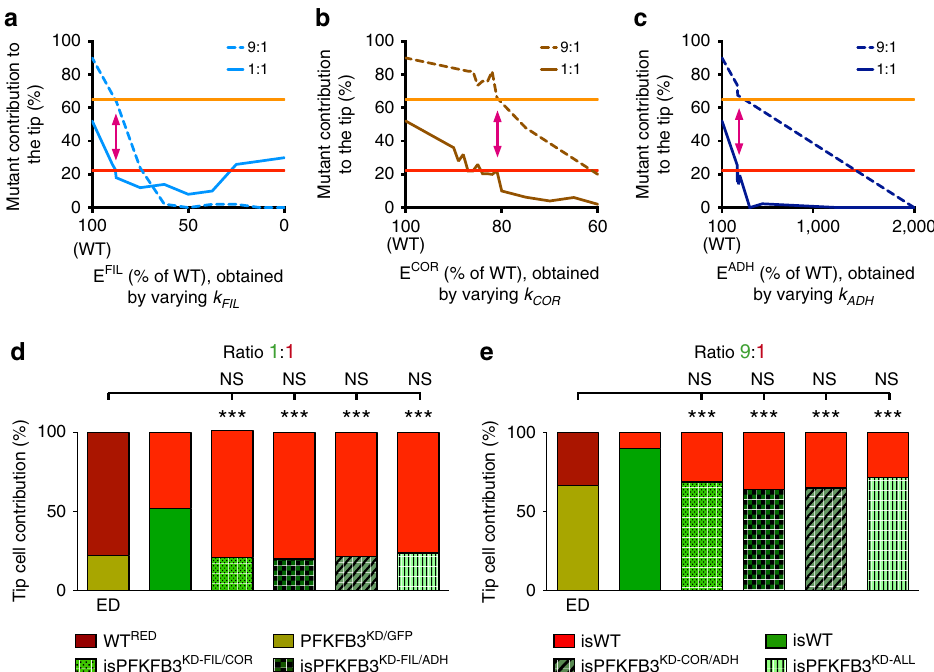
Figure 2 | Effector mechanism simulations of tip cell contribution. ( a–c ) Sensitivity analyses of respectively E FIL ( a ), E COR ( b ) and E ADH ( c ) as single mechanism governing tip cell competition, by varying over a wide range values of respectively k FIL , k COR and k ADH . The results for both the 1:1 (full line) and 9:1 (dashed line) in silico PFKFB3 KD :WT (isPFKFB3 KD :isWT) mosaic sprouts are shown. The red and orange horizontal line depict the tip cell contribution of PFKFB3 KD cells, as obtained experimentally in respectively the 1:1 and 9:1 PFKFB3 KD :WTsprouts 5 . The combined 1:1 and 9:1 simulation results yielded one specific k value (see pink double-headed arrow) for every single effector mechanism. ( d,e ) Combinatorial E FIL/COR , E FIL/ADH , E COR/ADH and E ALL simulations of tip cell contribution in 1:1 ( d ) or 9:1 ( e ) isPFKFB3 KD :isWT mosaic sprouts, illustrating that for every combinatorial effector, k values for its contributing effectors could be obtained matching the competitive disadvantage for PFKFB3 KD cells as observed in the experimental PFKFB3 KD :WT EC spheroid competition data (experimental data (ED), n ¼ 30 spheroids from 3 donors). For each combinatorial effector, the same k values matched both the 1:1 (first bar in d ) and 9:1 (first bar in e ) experimental mosaic PFKFB3 KD :WTsprout data. The second bar in panel d and e shows the expected 50% ( d ) or 90% ( e ) contribution of isWT cells in 1:1 ( d ) or 9:1 ( e ) isWT:isWT sprouts. n ¼ 150; *** P o 0.001, versus isWT:isWT. ‘NS’ (not significant) versus ED; Fisher’s exact